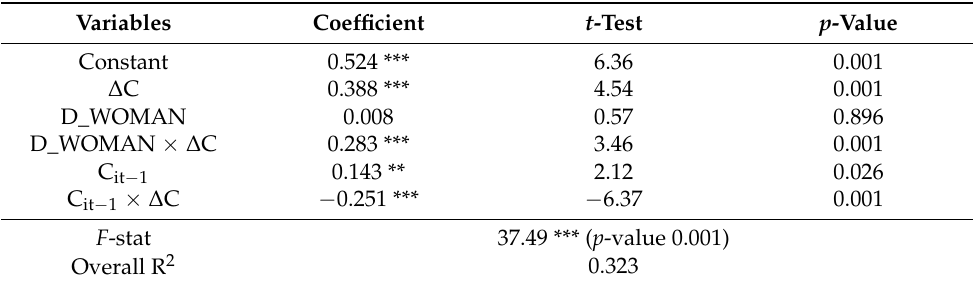
Table 9. Marginal value of cash and gender diversity.